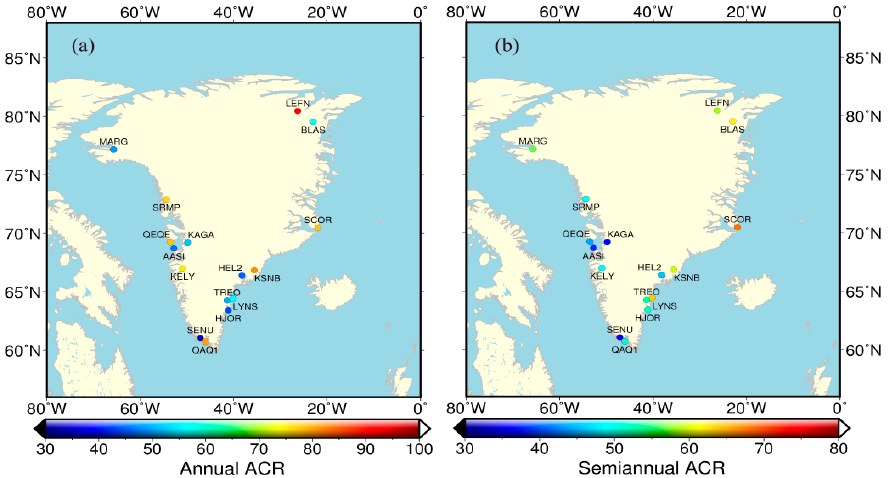
Figure 16. ACR value of GRACE mass load seasonal deformation on vertical annual ( a ) and semian- nual ( b ) signals of the station.